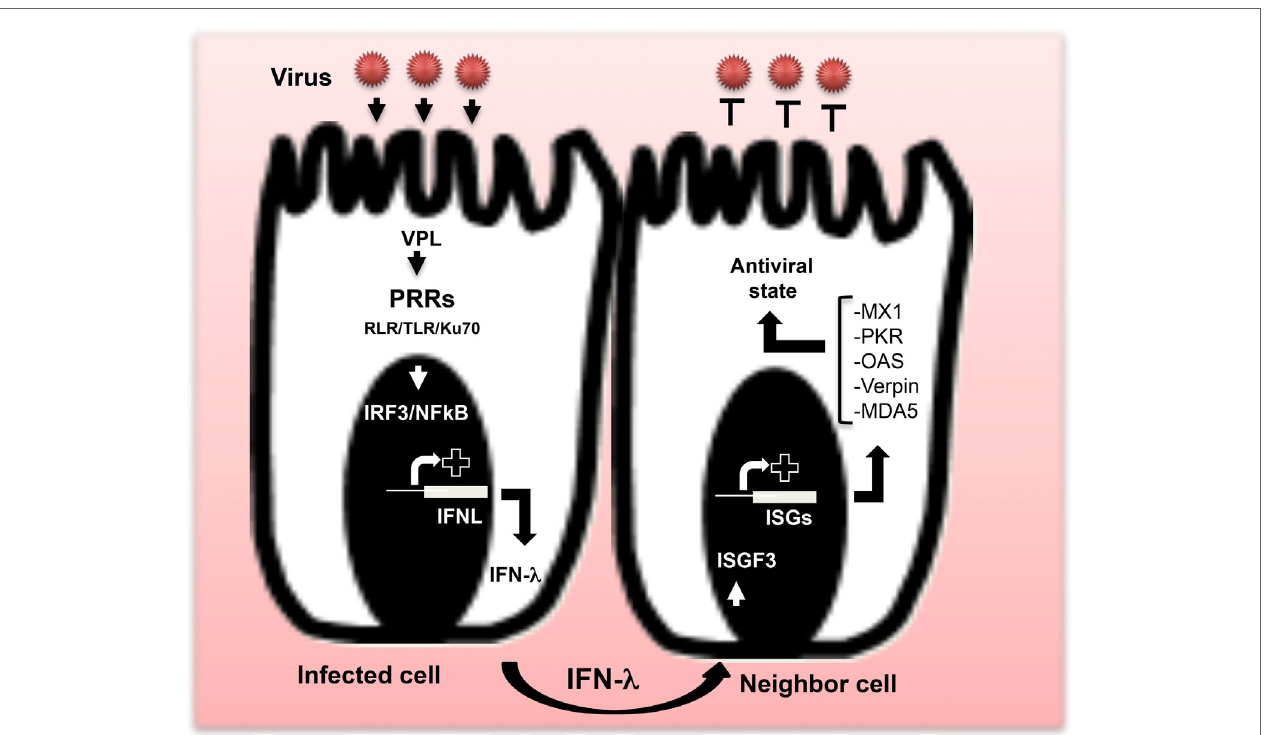
FiGURe 1 | Production of iFN- λ and establishment of the antiviral state . After virus attack, IFN- λ genes are induced. When viral particle ligands (VPL) are sensed by pattern recognition receptors (PRRs), particular transcription factors, mainly IRF-3 and NF- κ B, are induced to allow IFN- λ gene expression and subsequent release of IFN- λ proteins outside the infected cell. Dependent on the type of virus, various PRRs are involved, including members of the RIG-I-like receptor and toll-like receptor families, as well as the DNA sensor Ku70. Released IFN- λ induces an antiviral state in neighboring cells via the induction of interferon-stimulated gene factor leading to the expression of specific antiviral interferon-stimulated genes (ISGs), including myxovirus resistance 1, protein kinase R, melanoma differentiation-associated protein 5, verpin, and 2 ′ -5 ′ -oligoadenylate synthetase. Products of those antiviral ISGs inhibit virus replication and provide an antiviral state to